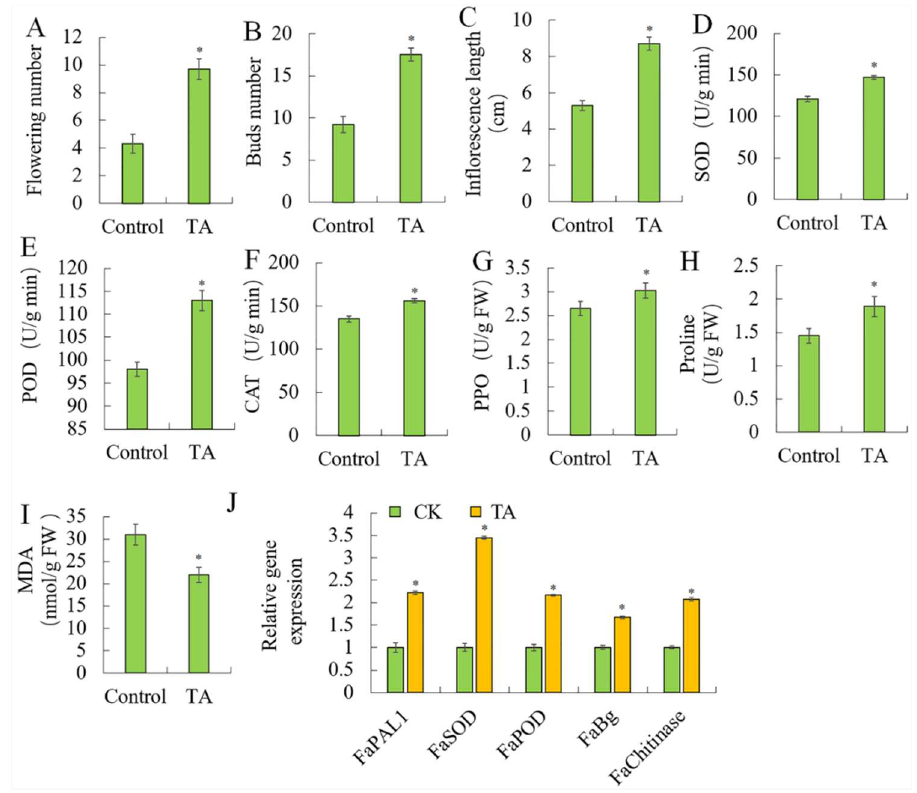
Figure 3. E ff ects of triacontanol on strawberry fruit stress resistance. ( A ). Number of flowers. Figure 3. Effects of triacontanol on strawberry fruit stress resistance. A . Number of flowers. B . ( B ). Number of buds. ( C ). Inflorescence length. Enzyme activities of ( D ). SOD (superoxide dismutase). Number of buds. C . Inflorescence length. Enzyme activities of D . SOD (superoxide dismutase). E . ( E ). POD (peroxidase). ( F ). CAT (catalase). ( G ). PPO (polyphenol oxidase). ( H ). Proline. ( I ). MDA POD (peroxidase). F . CAT (catalase). G . PPO (polyphenol oxidase). H . Proline. I . MDA (malondialdehyde). ( J ). Relative gene expression. Vertical bars represented standard deviations (SD) ( malondialdehyde ) . J . Relative gene expression. Vertical bars represented standard deviations (SD) of of means ( n = 3). Asterisks indicated statistically significant di ff erences at p < 0.05 as determined by means ( n = 3). Asterisks indicated statistically significant differences at p < 0.05 as determined by Student’s t Student’s t-test.